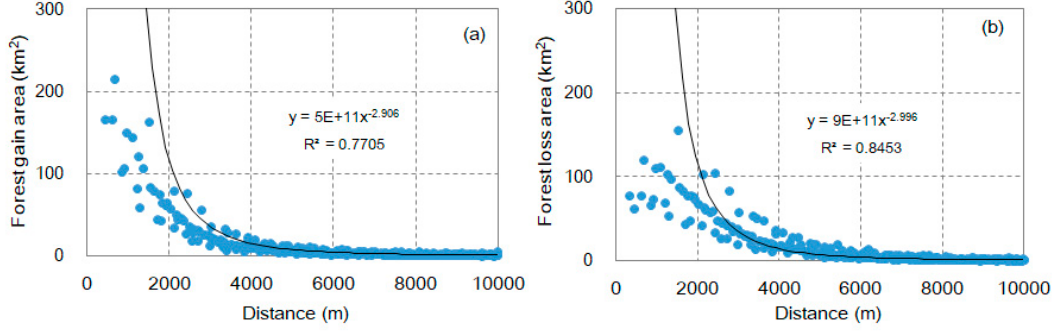
Figure 9. Forest changes analyzed by accessibility to settlements: forest gain ( a ) and forest loss ( b ).